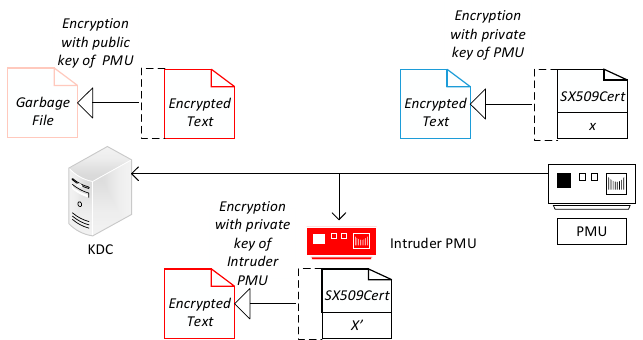
Figure 11. Intruder PMU sending its own certificate for authentication.